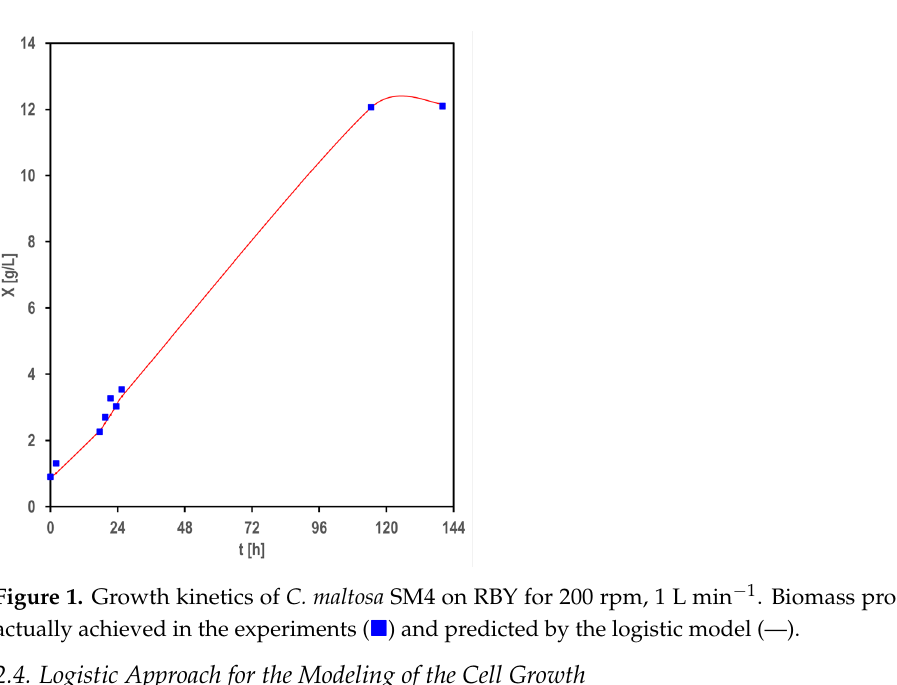
4 of 15 Table 1. Summary of results from the cultivation of C. maltosa SM4 in RBY. Mean values of tripli- cate experiments and standard deviations are presented. Agitation (rpm)